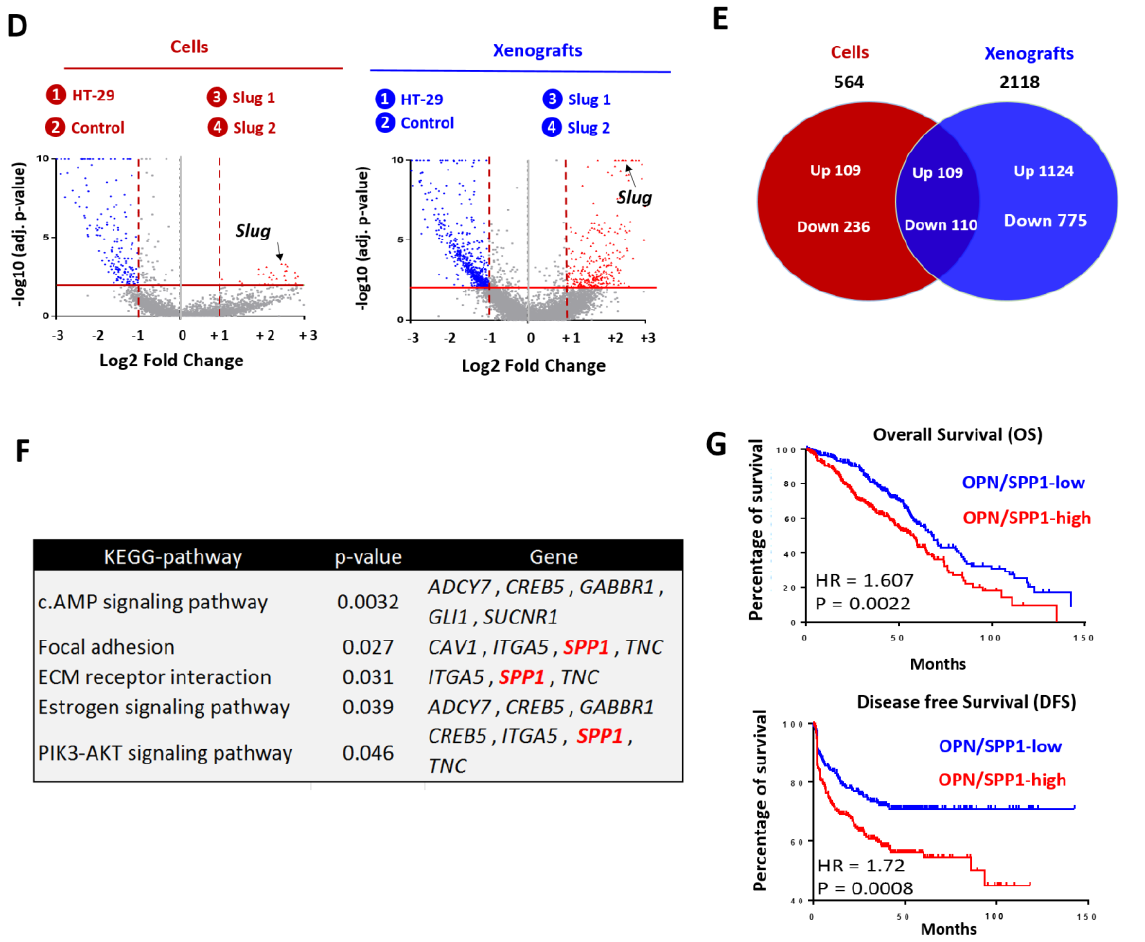
Figure 1. Influence of Slug/SNAI2 on global gene expression in CRC cells and tumors. ( A ) Expression of Slug mRNA in a genetic HT-29 model, including the parental HT-29 cells, the empty plasmid control and two stable Slug transfectants, Slug1 and Slug2. Symbols: *** p < 0.001 ( B ) Slug protein expression in the same four HT-29 models mentioned above. β -actin was used as loading control. ( C ) Heat map of the genes expressed by Slug1 and Slug2 cells and tumors compared to parental and control cells. Hierarchical clustering was performed by using the one minus Pearson correlation. Genes are considered to be significantly upregulated in the Slug transfectants, compared to controls, if the fold change (FC) is greater than 2, and considered to be downregulated if the FC is less than − 2 with p -values (false discovery rates) less than 0.01. ( D ) Volcano plots showing the significant genes present in the indicated cells or tumors. Downregulated genes are depicted in blue, and upregulated genes in red, while Slug expression is indicated by a red arrow (log2 fold-change (FC) vs. –l-log10 p -value). ( E ) Venn diagrams of the number of up-or downregulated genes in cells, tumors, and in both groups. ( F ) KEGG-pathway enrichment analysis of the up-regulated genes. SPP1 encoding osteopontin (OPN) is part of the signature for focal adhesion, extracellular matrix (ECM)–receptor interaction, and the PI3K-AKT signaling pathway. ( G ) Kaplan–Meier curves of overall survival (OS) on the left and disease-free survival (DFS) on the right, based on the expression of OPN in a meta-cohort of 1820 CRC patients